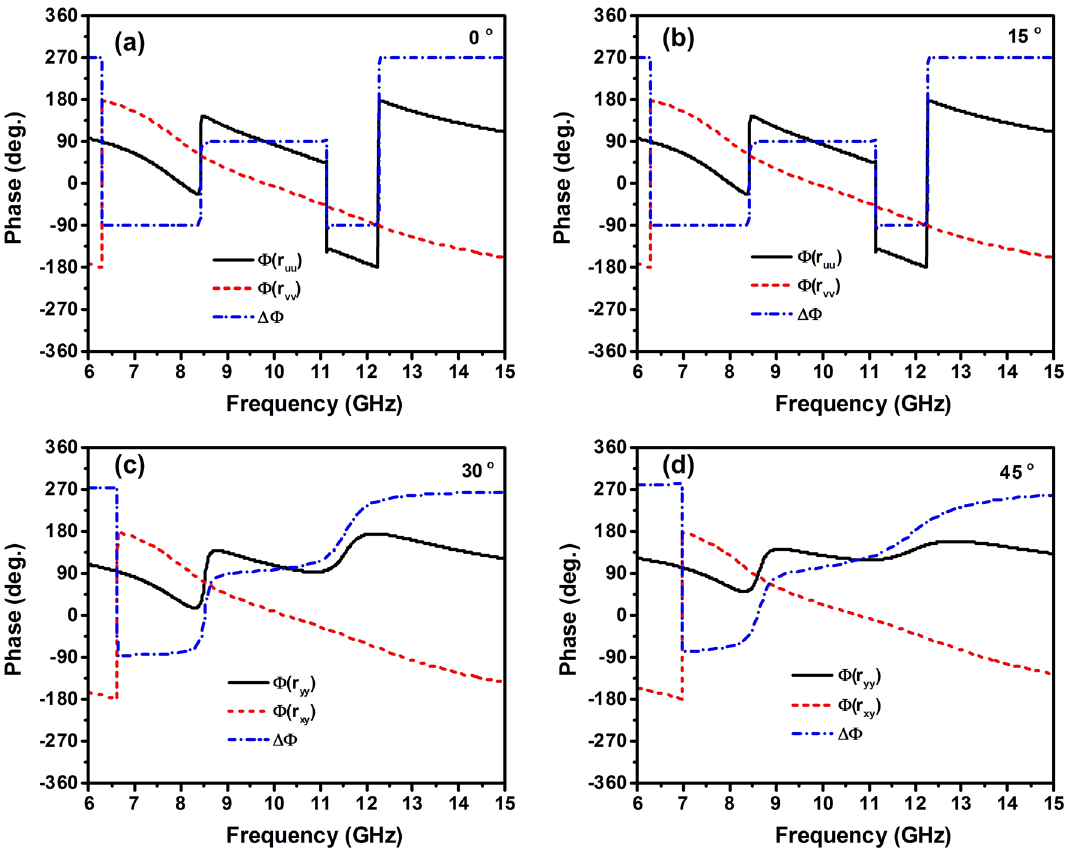
Figure 4. Phase of co- and cross-polarized reflection coefficients and their phase difference of the proposed polarization converter for various incident angles.